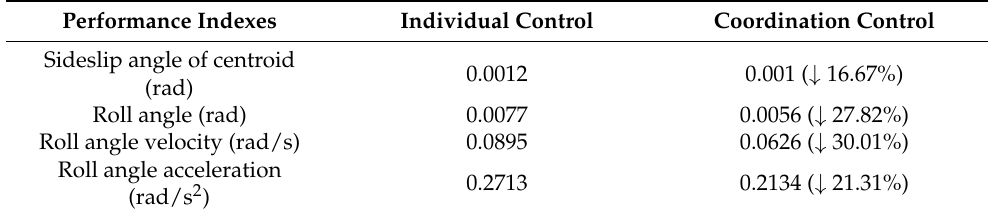
Table 5. RMS values of performance indexes under double line change conditions.